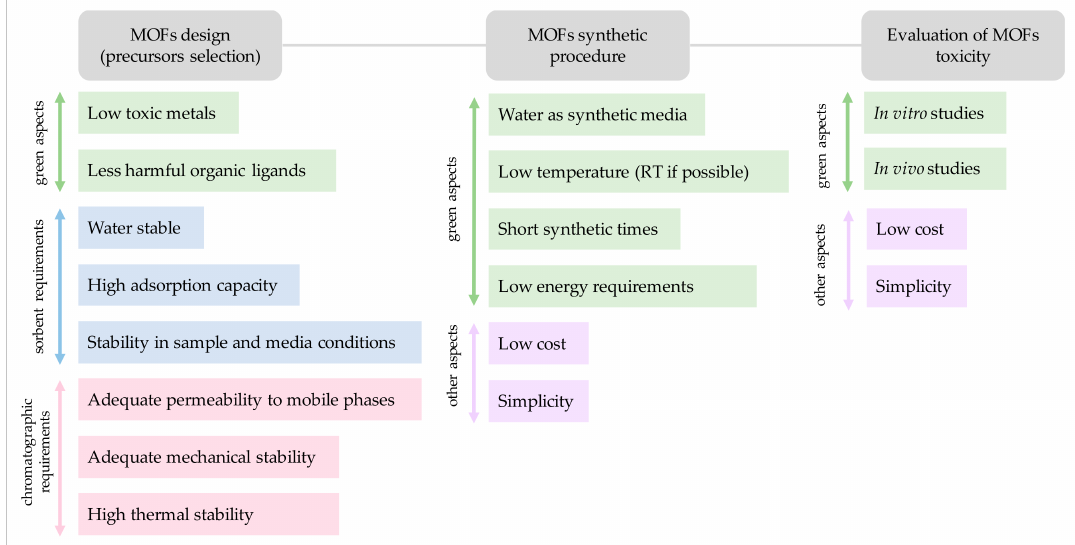
Figure 2. Considerations when preparing a MOF for analytical chemistry